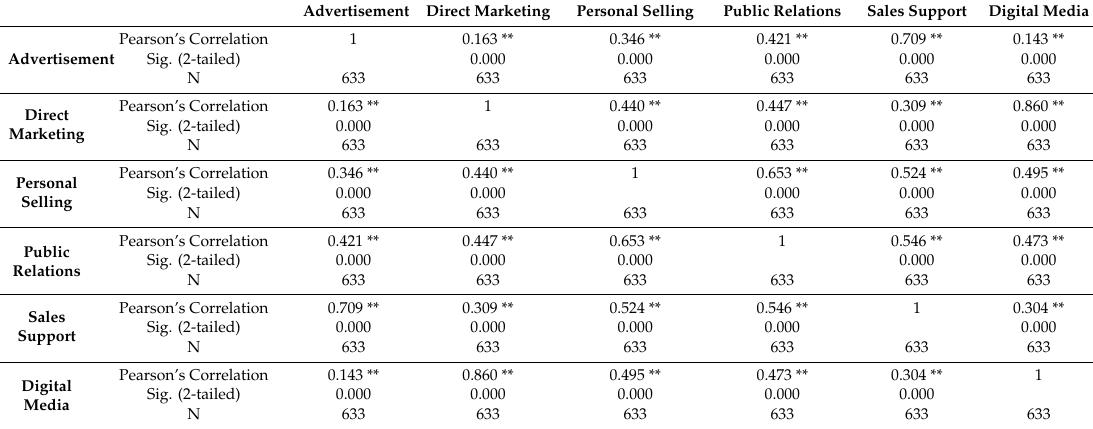
Table 1. Pearson’s correlation and the evaluation of Q1 and Q2